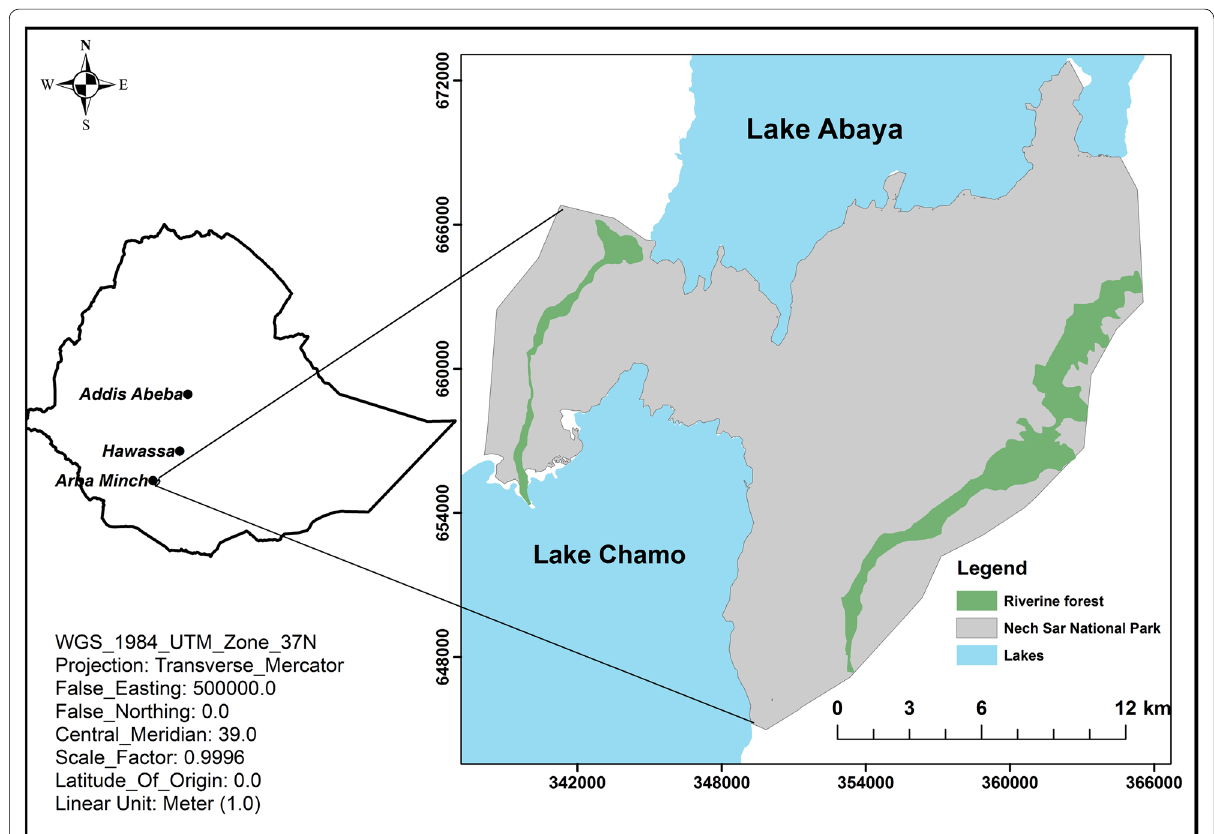
Fig. 1 Map of the study area showing different geographical